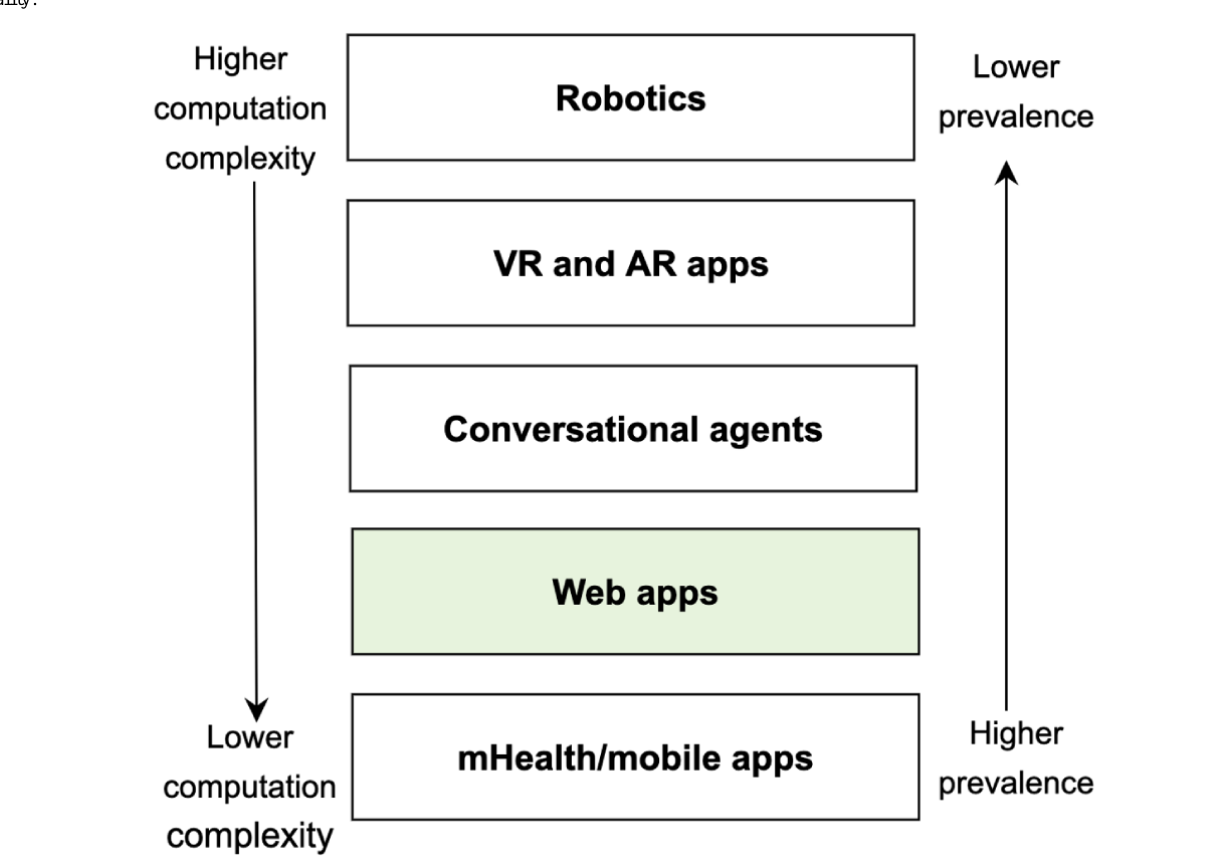
Figure 2. Mode of delivery for internet-delivered psychological treatments (IDPTs). AR: augmented reality; mHealth: mobile health; VR: virtual